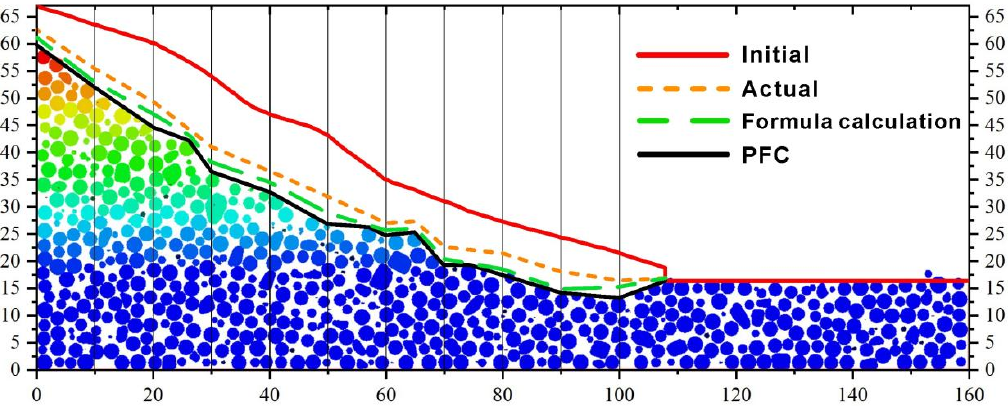
Figure 14. Comparison diagram of the final damage boundary.